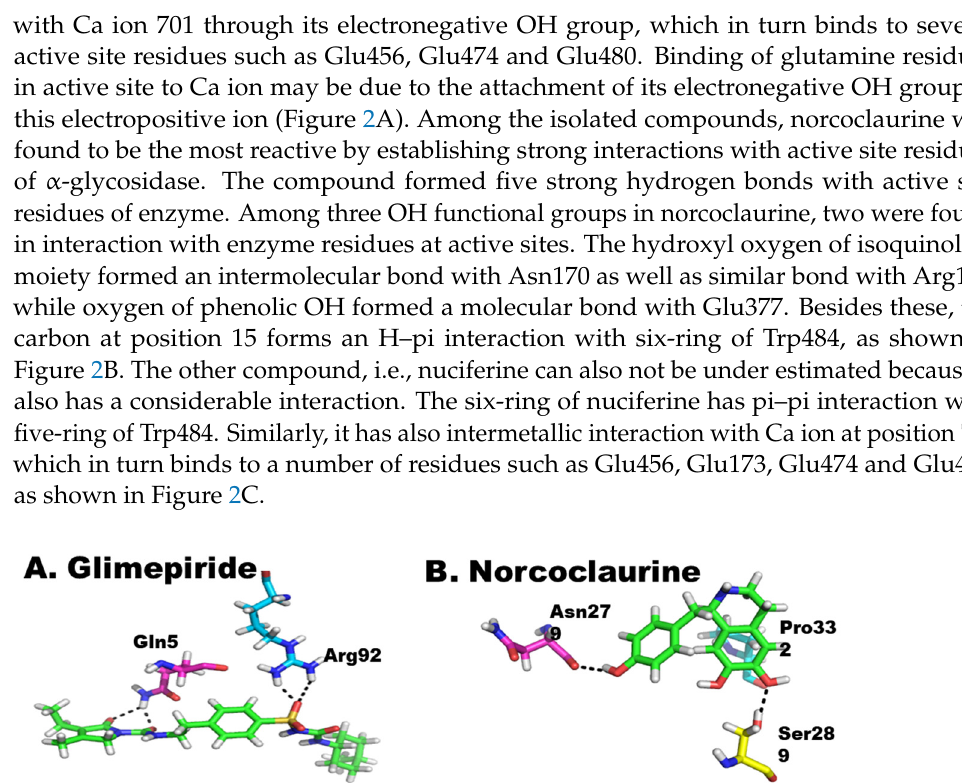
Figure 1. Nuciferine ( 1 ) and norcoclaurine ( 2 ) isolated from the seeds of N. nucifera.